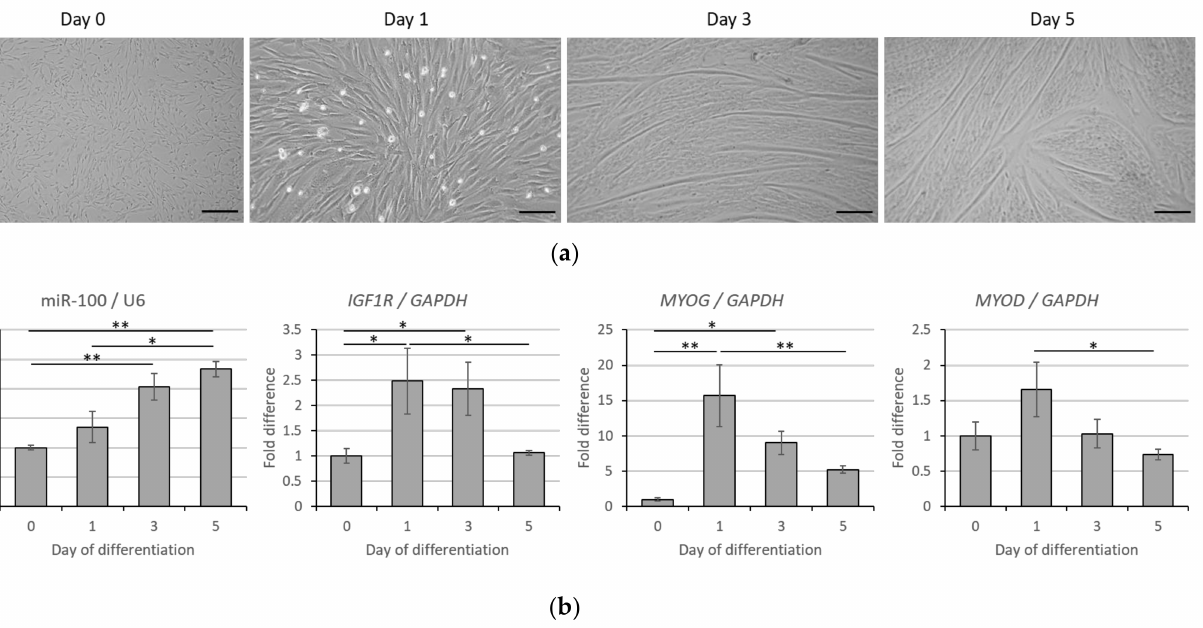
Figure 2. IGF1R and miR-100 expression during bovine muscle satellite cell differentiation. Mor- phology of cells on days 0, 1, 3, and 5 of myogenic differentiation ( a ) and transcript expression of miR-100 and IGF1R as well as of MYOG and MYOD for proper myogenic determination ( b ). Data is representative of four independent experimental replicates per sample group. Expression levels are presented as fold differences to day 0 and * and ** indicate significant differences among days with p < 0.05 and p < 0.01, respectively. Scale bar in ( a ) represents 200 µ m (day 0, 3, and 5) or 100 µ m (day 1),